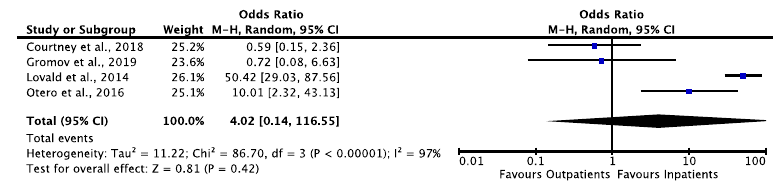
Forest plot of the comparison: Infections